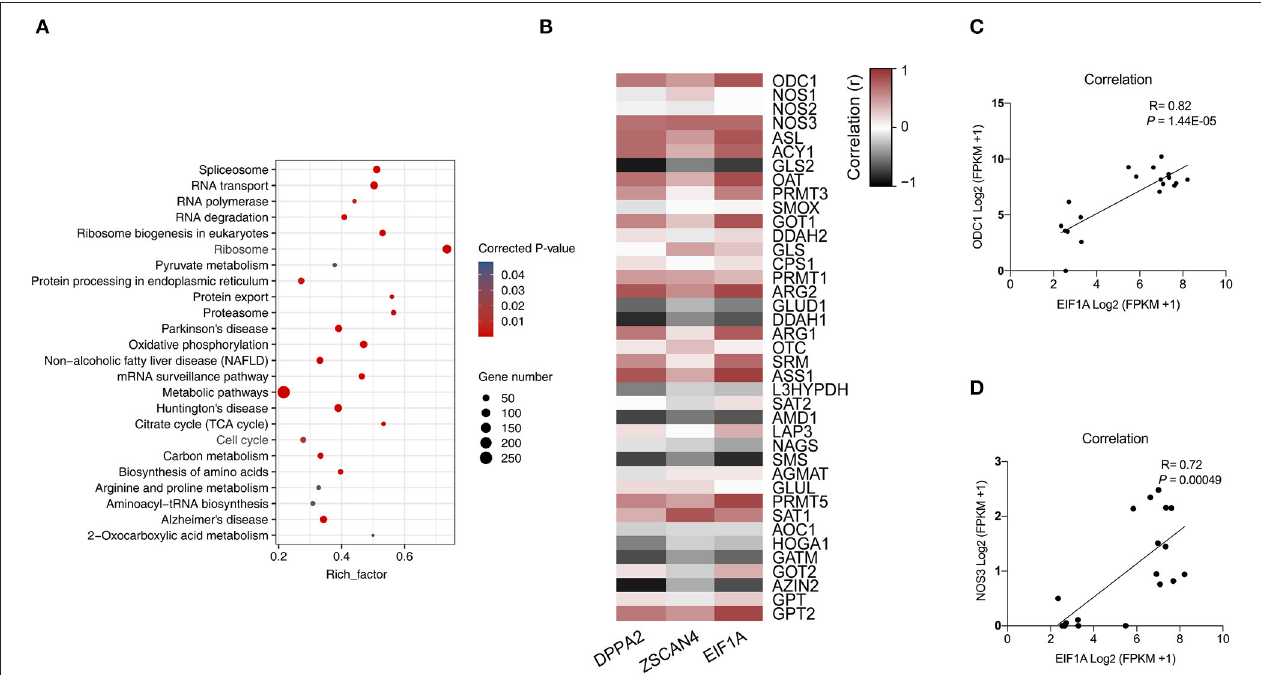
FIGURE 2 | Correlation analysis of arginine metabolism and ZGA. (A) This scatter plot shows the KEGG pathways that were significantly enriched among the differentially upregulated genes between 4-cell and 2-cell stage (3,226). (B) Heatmap of correlation of arginine metabolism-related genes and key ZGA genes. Red represents a positive correlation, and black represents a negative correlation. The closer the R value is to 1, the darker the color. (C) Scatter plot of the correlation between ODC1 gene and EIF1A gene expression. (D) Scatter plot of the correlation between NOS3 gene and EIF1A gene